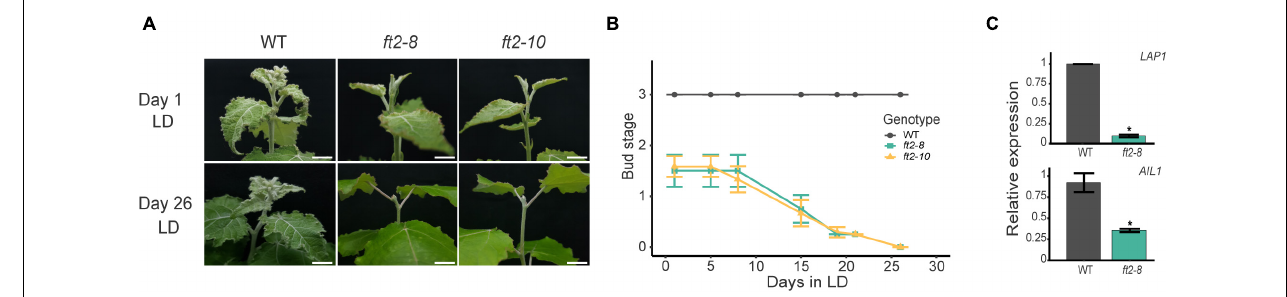
FIGURE 1 | FLOWERING LOCUS T2 (FT2) is essential for shoot development under long-day (LD) conditions. (A) Images of the shoot apex of the wild type (WT) and FT2 loss of function lines ft2-8 and ft2-10 . Top panels show pictures taken on Day 1 when the WT plants had reached stage 3. Bottom panels show pictures taken on Day 26, when ft2-8 and ft2-10 reached stage 0. Scale bar = 1 cm. (B) Line plot showing bud scores for WT, ft2-8, and ft2-10 plants collected until ft2-8 and ft2-10 reached stage 0. (C) Relative mRNA levels of LAP1 and AIL1 genes obtained from WT and ft2-8 apical buds. Ubiquitin7 was used as the housekeeping gene. Plotted values and error bars are fold-change means ± SD recorded in two biological replicates. Asterisks (*) represent significant differences assessed by one-way ANOVA ( p < 0.05) between genotypes.